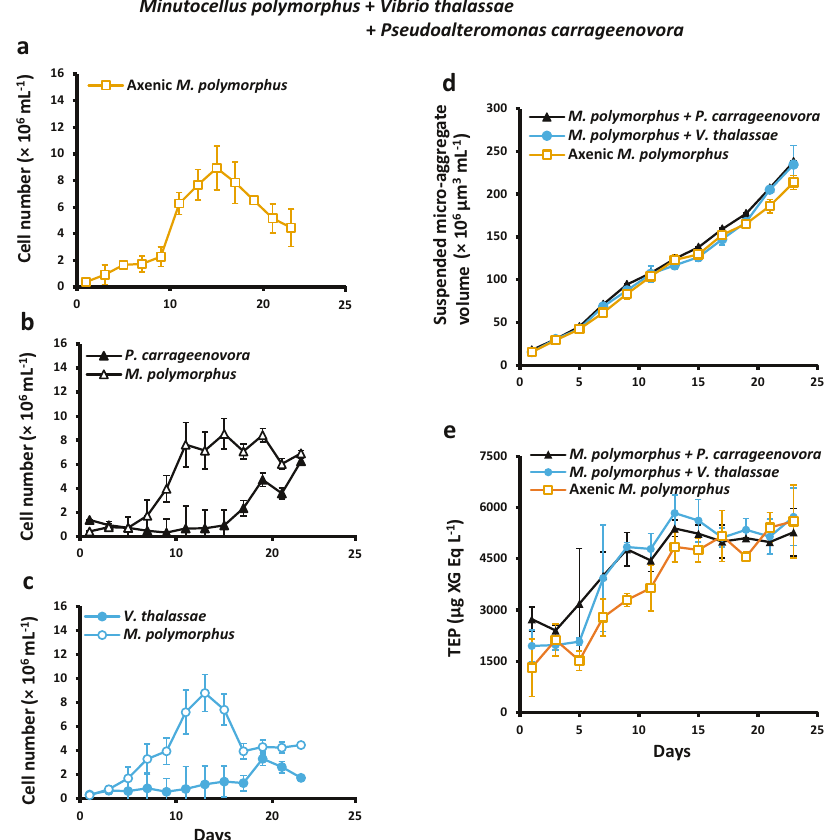
Fig. 2 Cell growth, TEP concentration, and micro-aggregate (5 – 60 μ m) volume concentration in Minutocellus polymorphus co-cultures with Vibrio thalassae and Pseudoalteromonas carrageenovora . Diatom cell concentration in growth experiment 2 with axenic Minutocellus polymorphus ( a ) and diatom and bacteria cell concentration in co-culture treatments with M. polymorphus and the addition of Pseudoalteromonas carrageenovora ( b ) or Vibrio thalassae ( c ), as well as total volume of suspended micro-aggregates ( d ) and transparent exopolymeric particle (TEP) concentrations ( e ) in all treatments. Symbols and error bars denote the means and standard deviations of triplicate